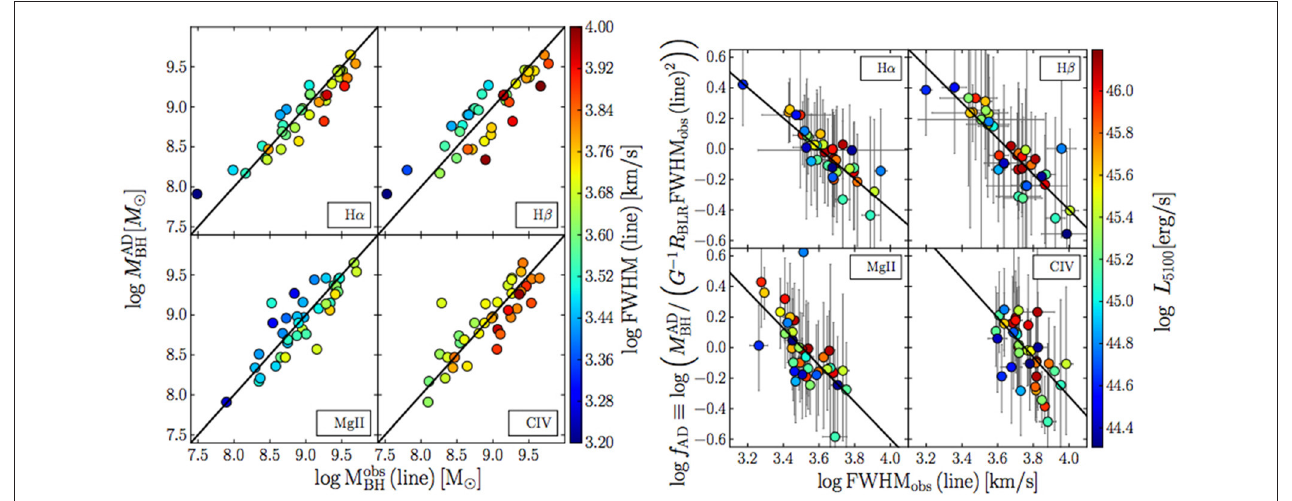
FIGURE 1 | Comparison of black hole mass estimations from the single epoch virial method and the accretion disk modeling Left: log M AD BH vs. log M SE BH ( FWHM, L λ ) . The color of the points in each panel represent the FWHMs of the labeled emission lines in each panel as indicated in the color bar. The black solid line represents the 1:1 relation. Right: log f AD ( lines ) vs. log FWHM ( line ) . The color of the points in each panel represents the monochromatic luminosity L 5100 as indicated in the color bar. The black solid line represents the best linear fit the observed relations.